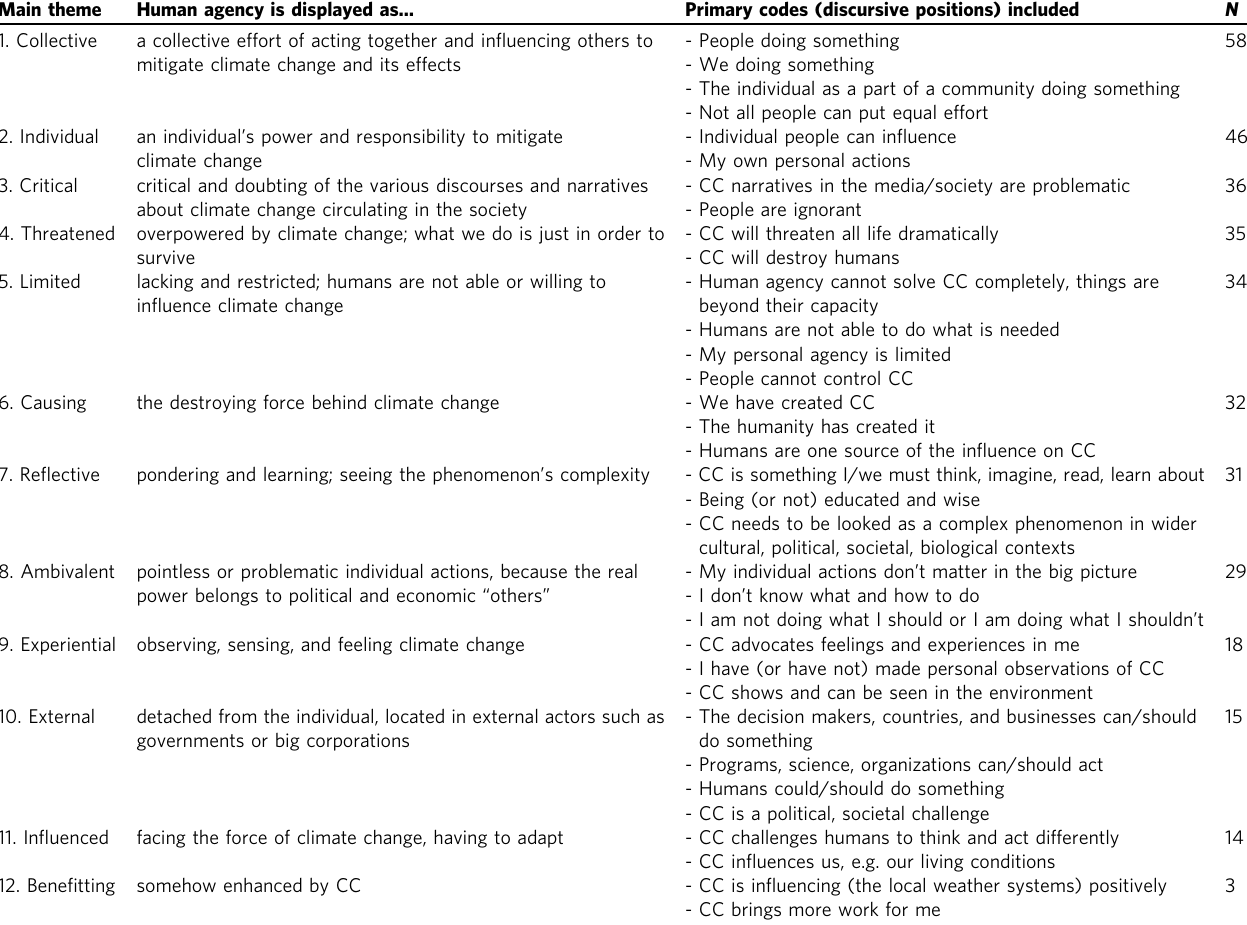
Table 1 Themes of climate change